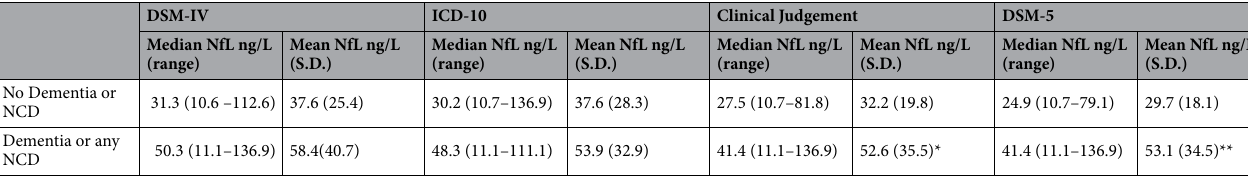
Table 3. Grouped analysis of average NfL levels per diagnostic criteria, comparing no dementia and dementia. *Between group significance p < 0.05. **Between group significance p < 0.01.